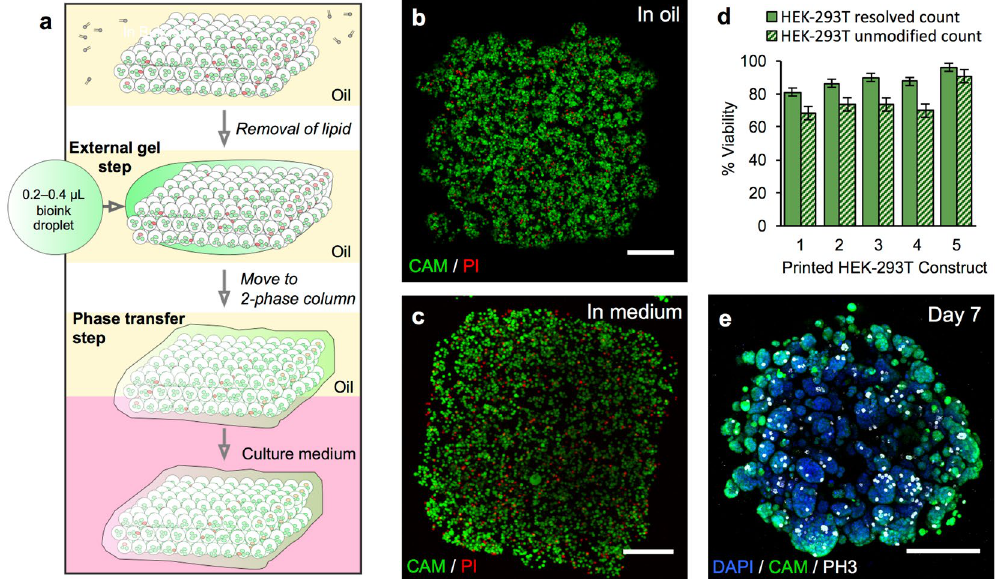
Figure 3. Phase transfer and culture of printed constructs containing HEK-293T cells. ( a ) Gel encapsulation of a printed construct and phase transfer. The printed cellular construct was gelled by standing at 4 °C for 20 to 25 min and the lipid in the oil was removed by washes with silicone oil AR20 at room temperature. The construct was then coated with a thin layer of cell-free bioink, which was gelled by standing at 4 °C for 20 to 25 min. The gelled construct was then transferred into the upper phase of an oil-culture medium two-phase system. The construct fell through the oil into the culture medium. ( b ) Image of a z-stack 3D reconstruction of live/dead-stained HEK-293T cells printed as a cuboid construct (7 × 8 × 4 droplets) immediately after printing under oil. The printed droplets had a mean density of 2.9 × 10 7 cells mL − 1 with a viability of 96%. (Scale bar = 200 μ m). ( c ) Image of a z-stack 3D reconstruction of live/dead-stained printed HEK-293T cells after gel encapsulation and transfer to culture medium. (Scale bar = 200 μ m). ( d ) Graph showing HEK-293T cell viability (including standard error of the mean) of five printed constructs at day 0 after transfer to culture medium. Viabilities were determined by using automated object counting, values of which were used either unmodified or resolved with respect to mean cell size. ( e ) Image of a z-stack 3D reconstruction of immunocytochemistry performed on a construct in culture medium at day 7: cell nuclei (DAPI, blue); cytoplasm of live cells (CAM, green) and; mitotic marker (phospho-histone H3 ICC, PH3, white). (Scale bar = 200 μ